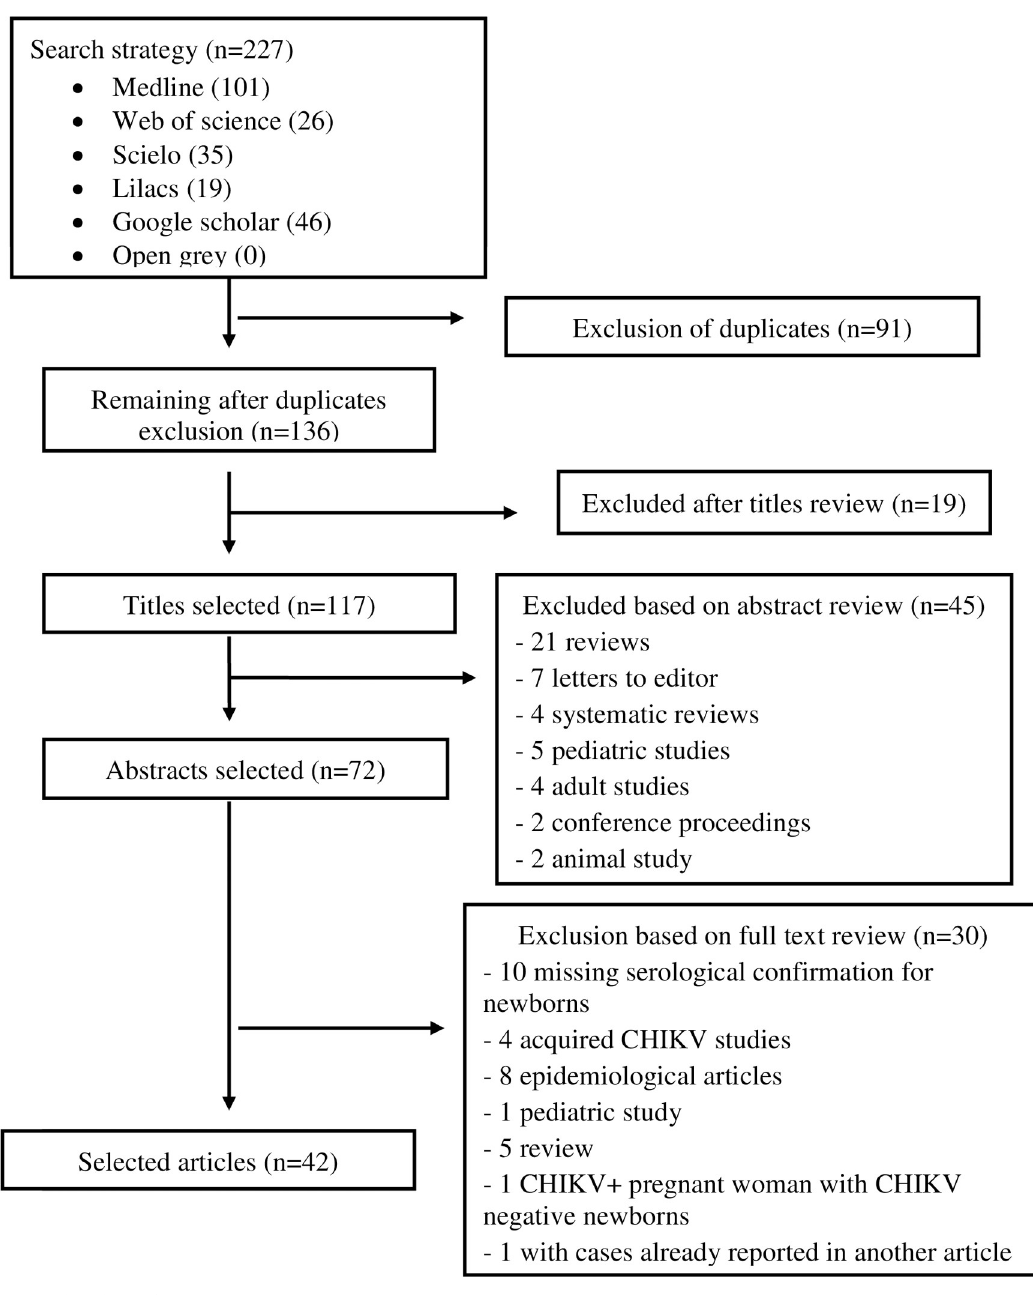
Fig 1. Flowchart of review